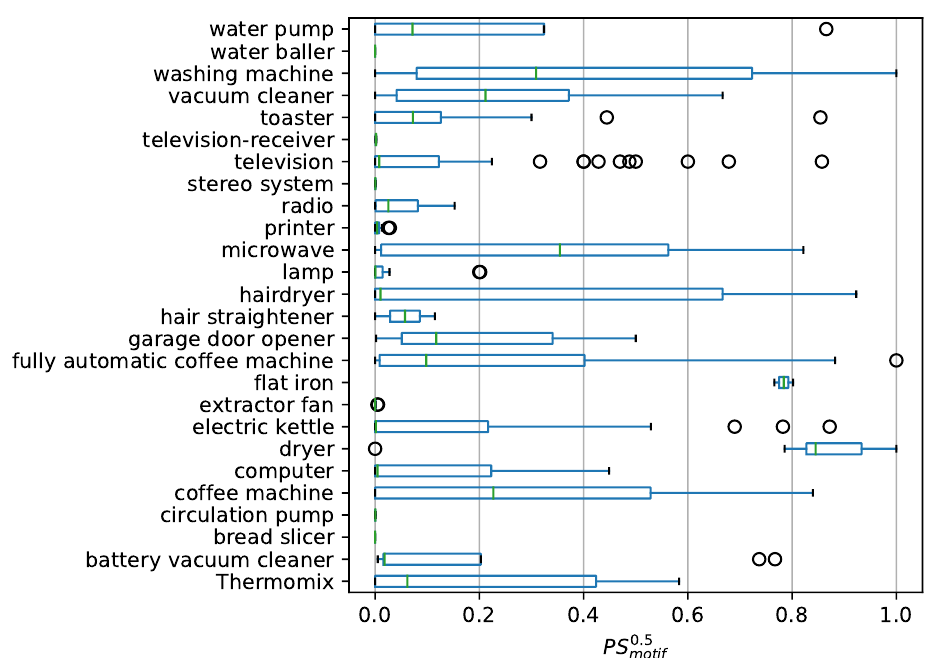
Figure 6. Box plot on PS 0.5 for all extracted motifs motif n ∈ M grouped by appliance. motif n